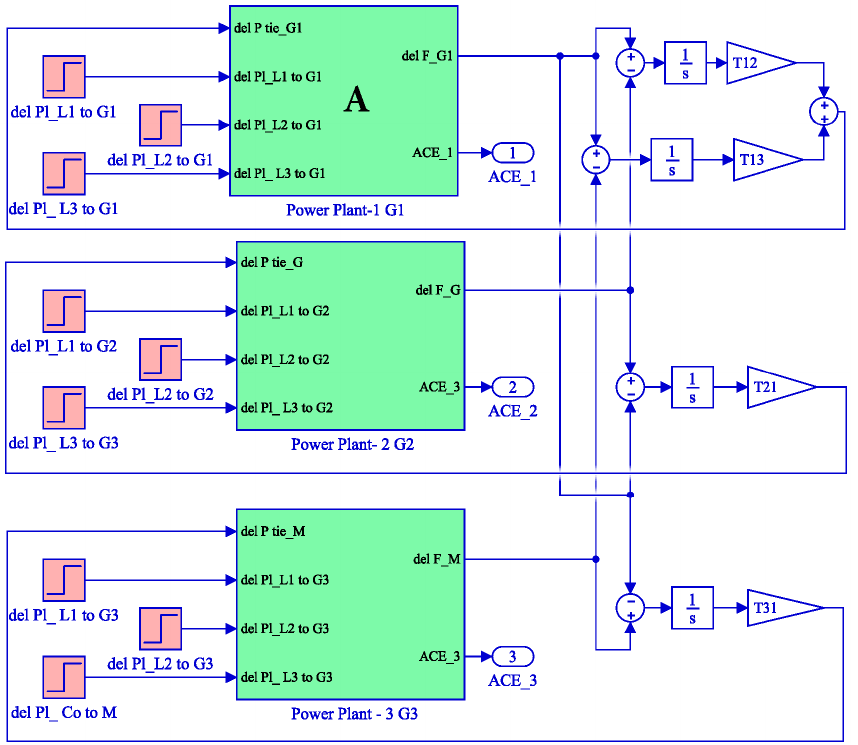
Figure 5. Dynamic model of interconnected power system for ADRC-based LFC.